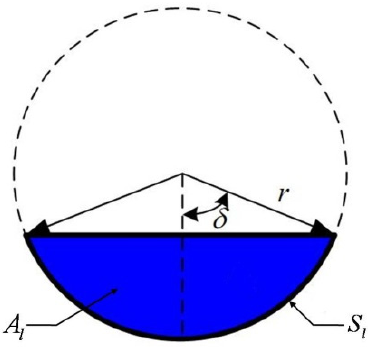
Figure 2. Schematic diagram of open channel flow.